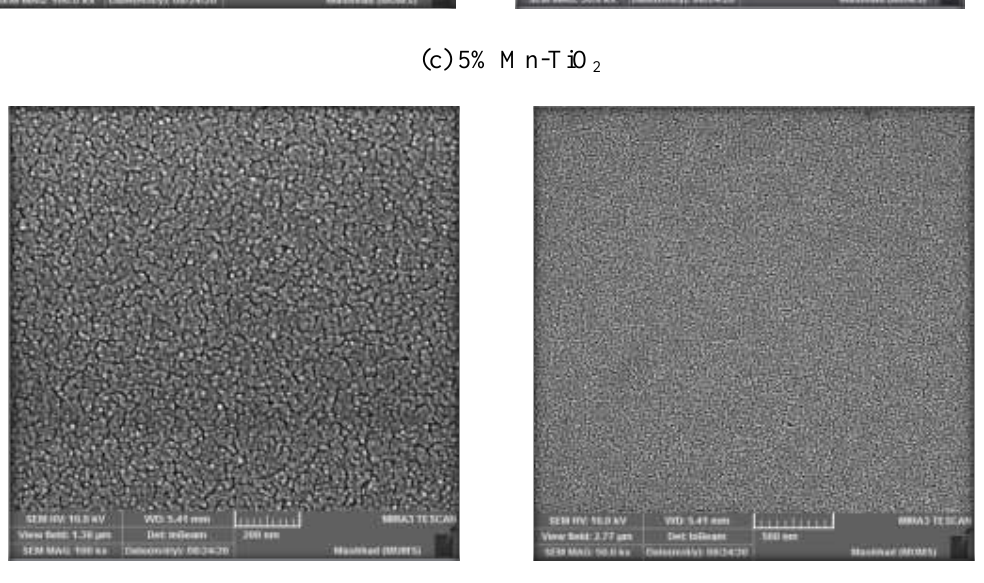
Fig.4: SEM images of Mn-doped TiO